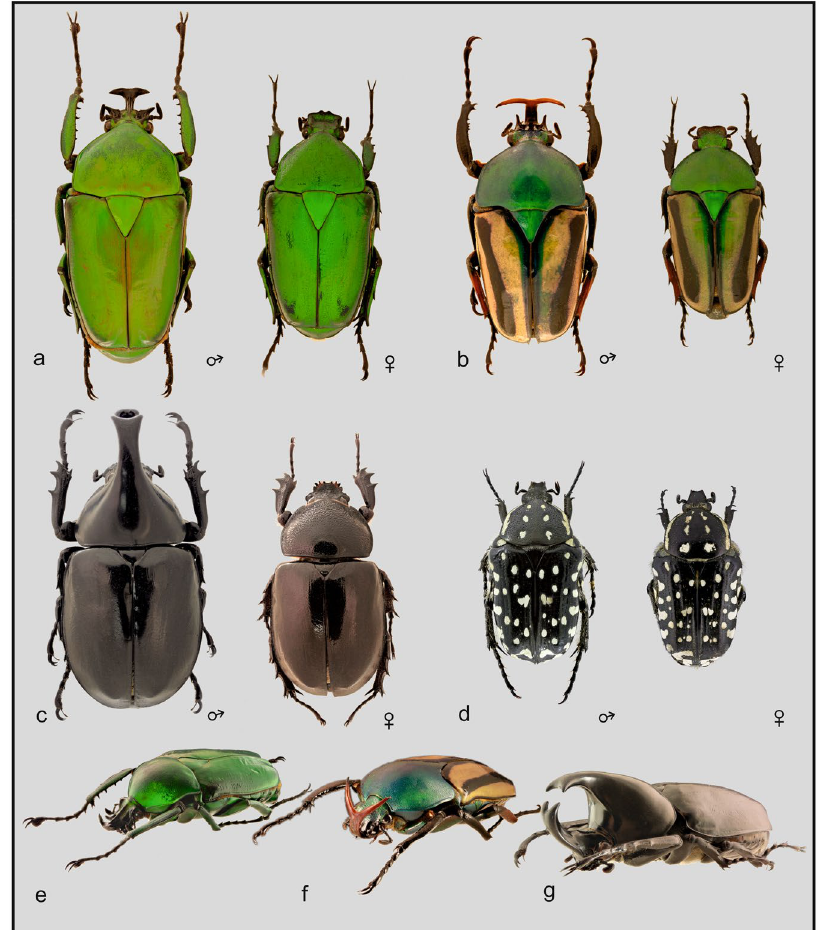
Figure 1. Male and female of Dicronorhina micans ( a ), Eudicella gralli ( b ) and Xylotrupes gideon ( c ). In Oxythyrea pantherina ( d ), a presence of the ventral abdominal line of white spots in males is the only external difference between sexes. Figures not to scale; the real sizes of the males and females are as follows: 49 mm and 40 mm in D . micans , 38 mm and 32 mm in E . gralli , 53 mm and 41 mm in X . gideon , and 11 mm in the case of the male and female of O . pantherina . ( e – g ) frontolateral views of males of the dimorphic species. (Photo of O . pantherina courtesy of D.